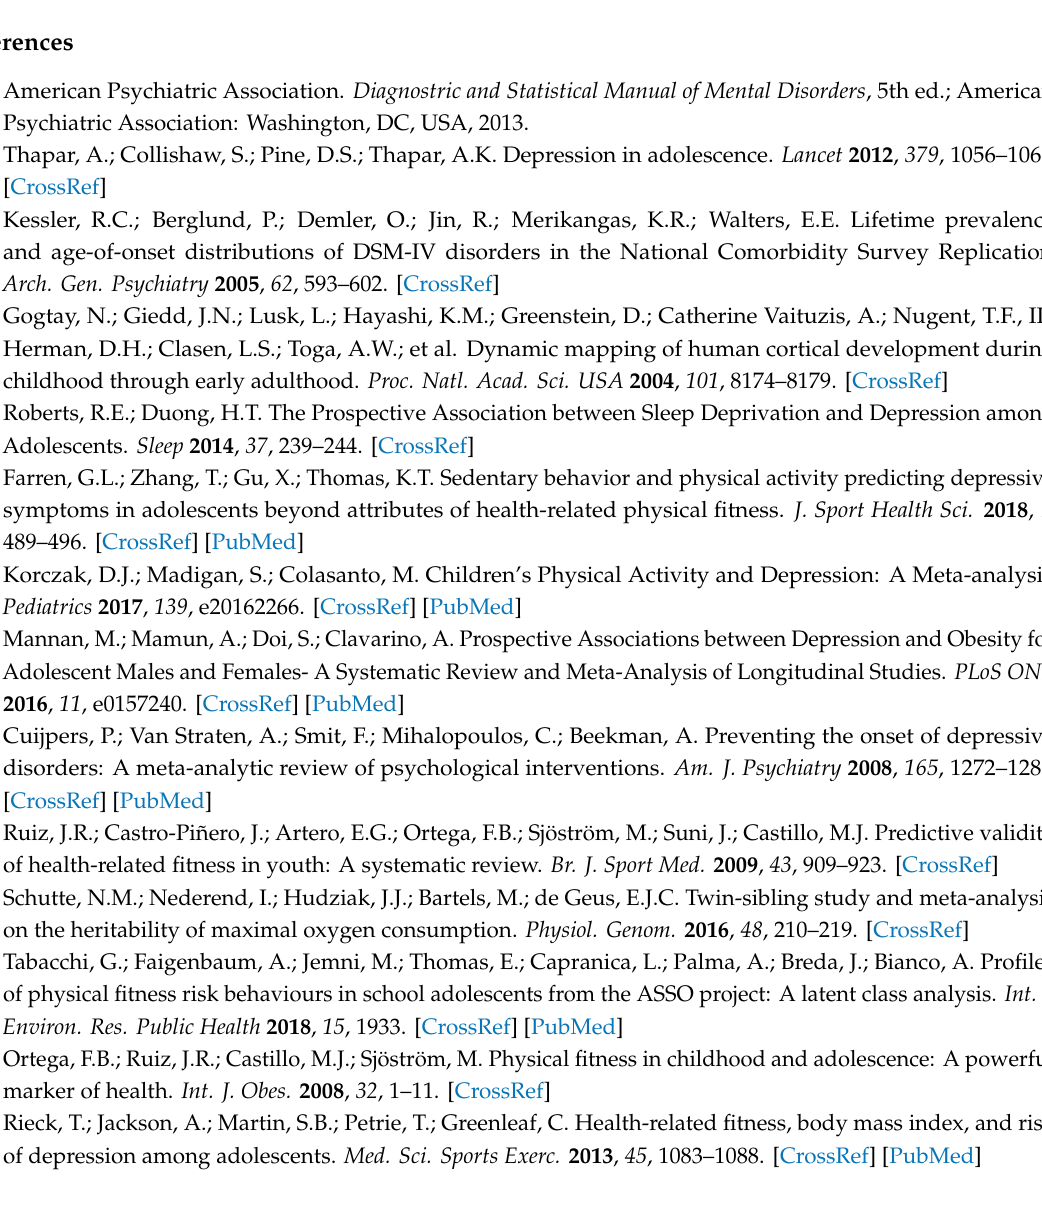
Table S1: Partial correlations analyses of health-related physical fitness components and self-reported risk of depression